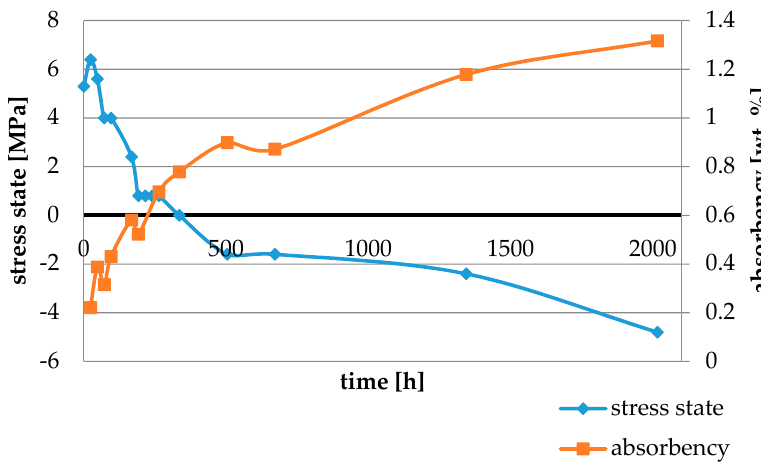
Figure 7. The influence of water sorption (2016 h water ageing) on the absorbency and contraction stress generated during the photopolymerization of Panavia 2.0.